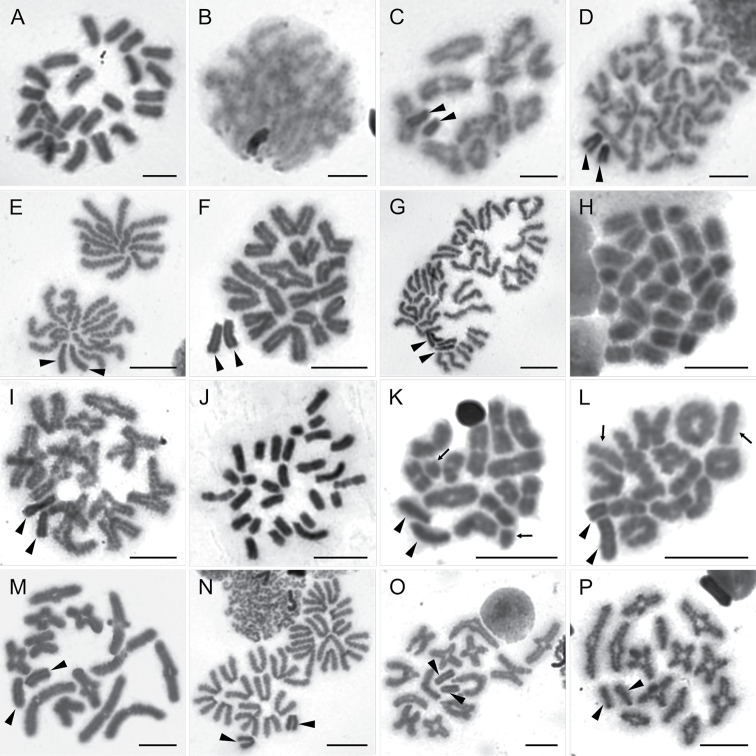
Chromosomes of Cheiracanthiidae (A–D) and Salticidae (E–P). Cheiramiona
kirkspriggsi (2n♂ = 24, X1X20) A mitotic metaphase B pachytene, sex chromosomes associate on the periphery of nucleus C diakinesis with positively heteropycnotic X1X2D metaphase II EBaryphas
ahenus, (2n♂ = 28, X1X20) prometaphase II. Cyrba
lineata (2n♂ = 28, X1X20) F diakinesis G metaphase II. Holcolaetis
zuluensis (2n♂ = 28, X1X20) H mitotic metaphase I diakinesis, with positively heteropycnotic X1X2. Myrmarachne
laurentina (2n♂ = 28, X1X20) J mitotic metaphase K early metaphase I, note one bivalent with early segregation (arrows) LMenemerus
minshullae (2n♂ = 28, X1X20) diakinesis, note one bivalent with early segregation (arrows) M Diakinesis of Nigorella
hirsuta (2n♂ = 28, X1X20) N Metaphase II of Thyene
ogdeni (2n♂ = 28, X1X20) X1X2 are positively heteropycnotic OThyenula
haddadi (2n♂ = 28, X1X20) diakinesis PThyenula
leighi (2n♂ = 28, X1X20) diakinesis. Arrowheads indicate sex chromosomes. Scale bars: 5 μm (A–D), 10 μm (E–P).